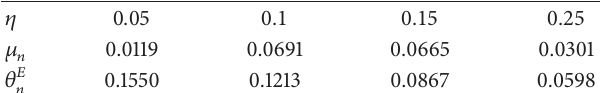
Table 1: Einstein rings and magnifications ( 𝑛 = 1 ) for ordinary global monopole.